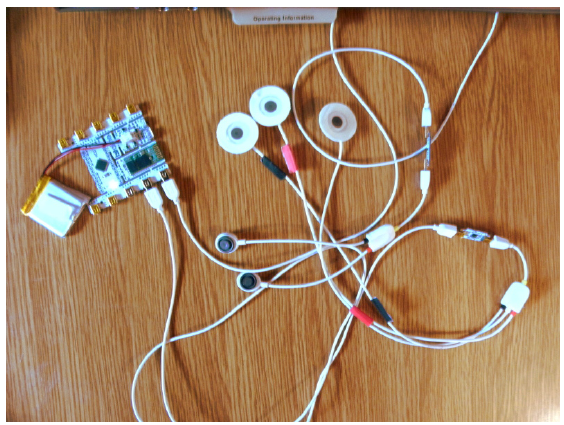
Figure 2. BITalino (r)evolution kit: Basic components [35].